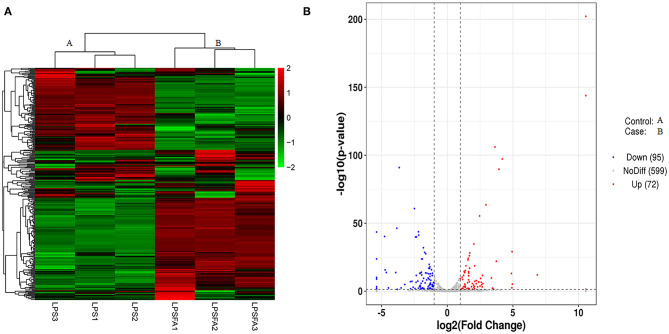
Comparison of miRNA expression patterns between lipopolysaccharide (LPS) and forsythoside A (FTA) + LPS groups. (A) Heat map of differentially expressed miRNAs. High and low expression levels of miRNA are shown in red and green, respectively. Each group included three biological repeats. (B) A volcano plot of differentially expressed miRNAs. Differences in miRNA up-regulation, down-regulation, and unchanged levels are represented by red, blue, and gray points, respectively.